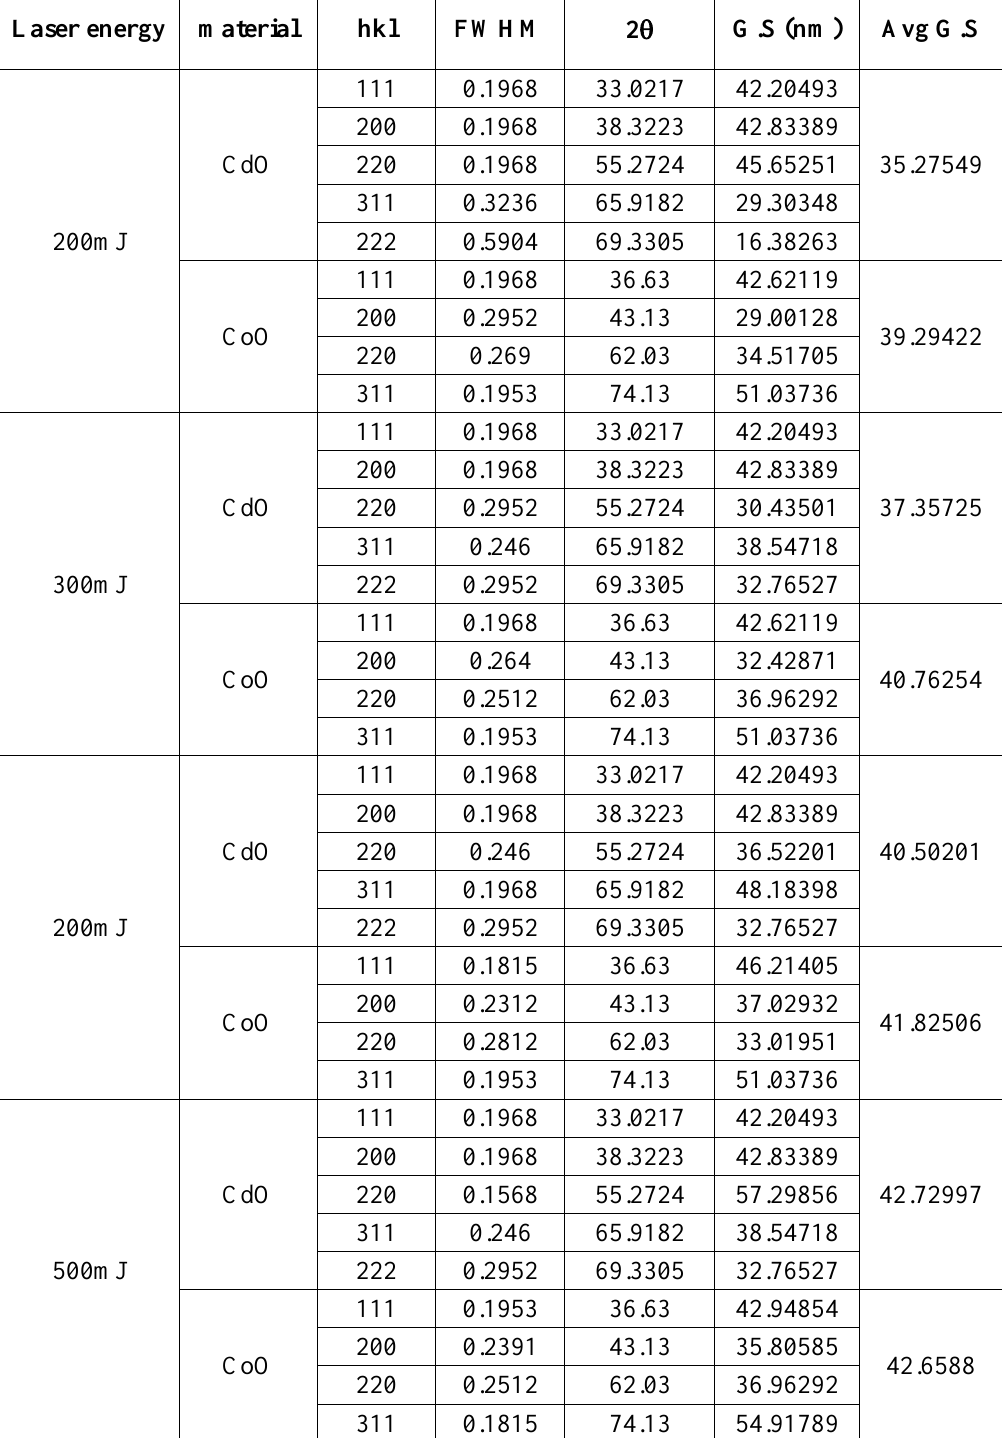
Table 1: The results of X-ray examination of CdO:CoO thin films deposited with different